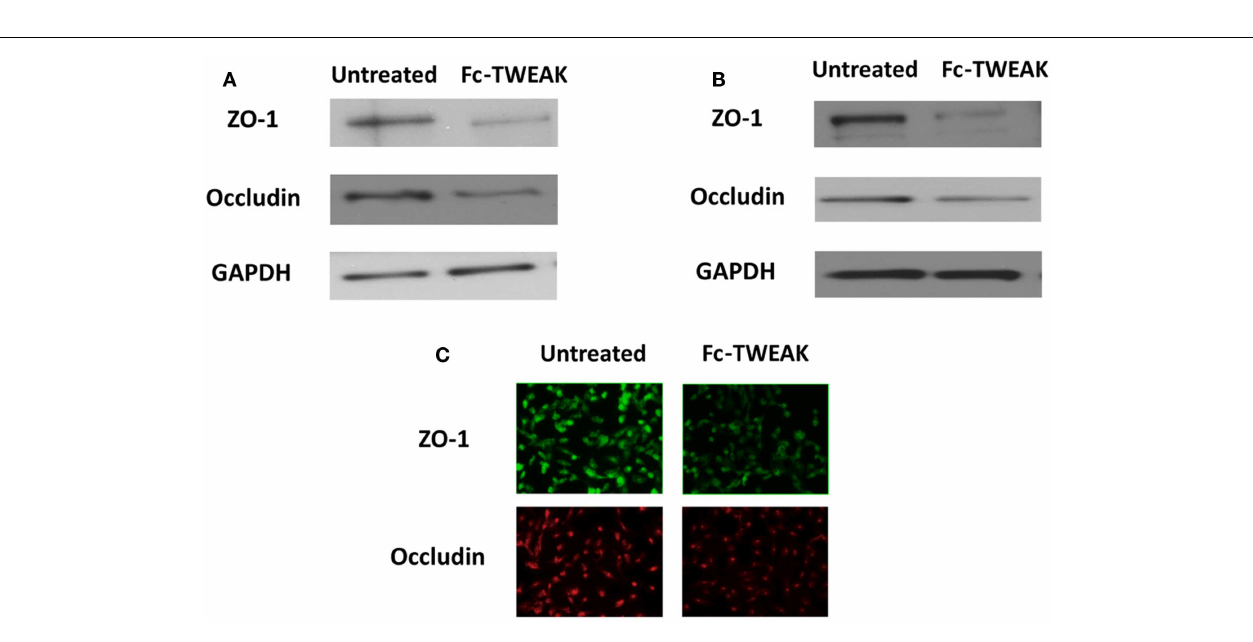
decreased in hBMEC cells after treatment with Fc-TWEAK (100ng/mL, 24h) as well (B) . Similarly, immunofluorescent detection of ZO-1 and occludin in hBMECs was reduced after treatment with Fc-TWEAK (100ng/mL, 24h) (C) .